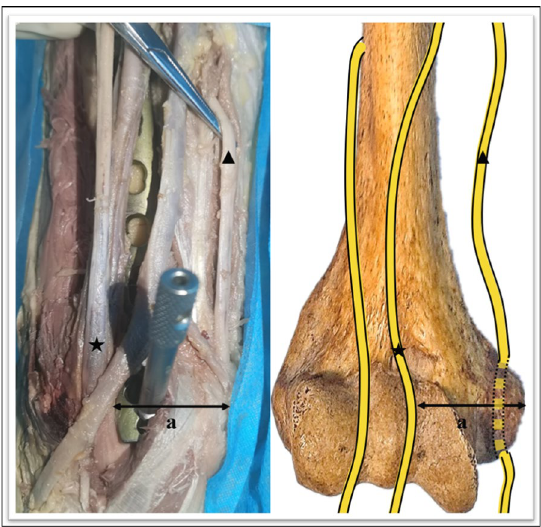
Fig. 3 This figure shows the vertical distance from the vertex of the medial epicondyle to the median nerve ( a ). The pentagrams indicate the median nerves. Triangles indicate ulnar nerves